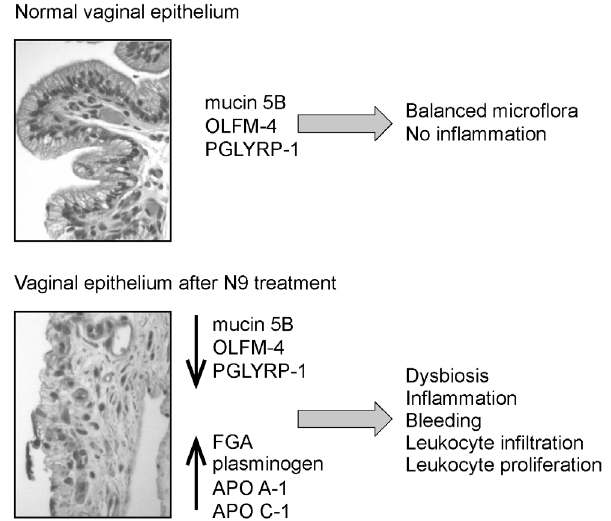
Figure 7. Model for the protective roles of mucin 5B, olfactomedin-4 (OLFM-4), and peptidoglycan recognition pro- tein 1 (PGLYRP-1) in vaginal epithelium. In normal epithelium (top) these proteins maintain a balanced microflora and suppress inflammation. However, when exposed to toxic microbicides such as N9 (bottom) the epithelium becomes inflamed causing bleeding and release of serum proteins into the vaginal cavity. In addition, the microflora is altered leading to dysbiosis which could boost the inflammation response. The result is an influx and expansion of leukocytes that may be susceptible to